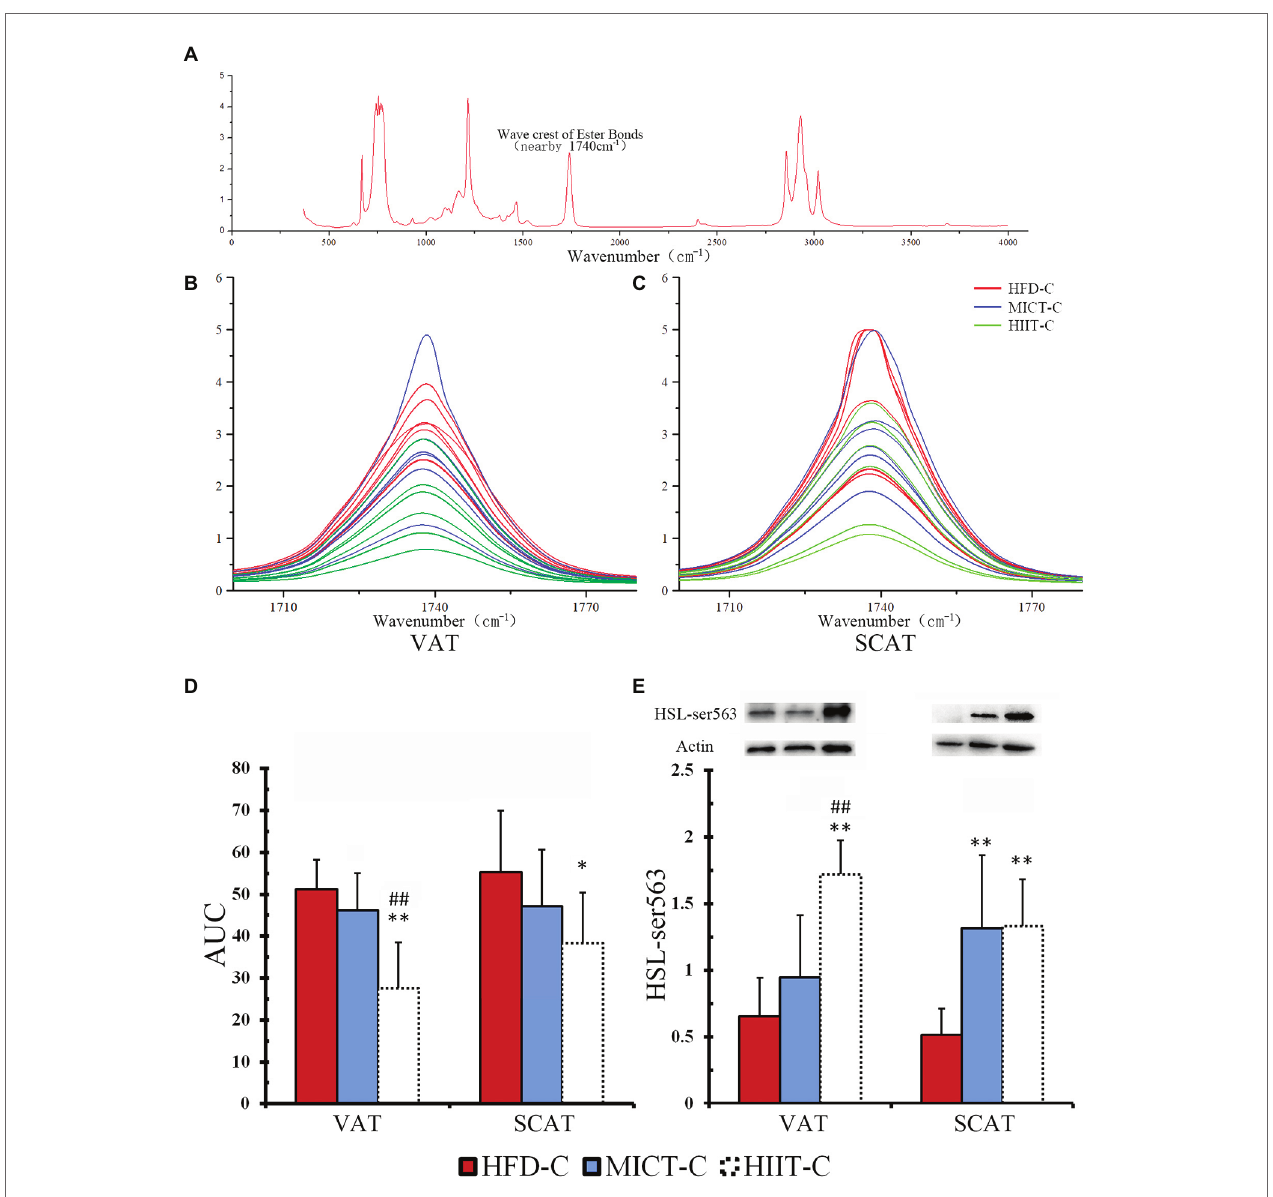
FIGURE 7 | A complete FTIR spectrum (A) is shown, including a peak nearby 1,740 cm −1 representing the quantity of triglyceride bonds. Peaks of VAT (B) and SCAT (C) are overlapped to show the difference between HFD-C, MICT-C, and HIIT-C. The area under the curve (AUC), representing the quantity of triglyceride bonds. Differences are shown in the amount of triglyceride bonds (D) and HSL-Ser563 phosphorylation (E) between HFD-C, MICT-C, and HIIT-C after physiological concentration of epinephrine stimulation (simulated fasting in vitro ). * p < 0.05 vs. HFD-C; ** p < 0.01 vs. HFD-C; and ## p < 0.01 HIIT-C vs. MICT-C. Bands shown are representative for overall